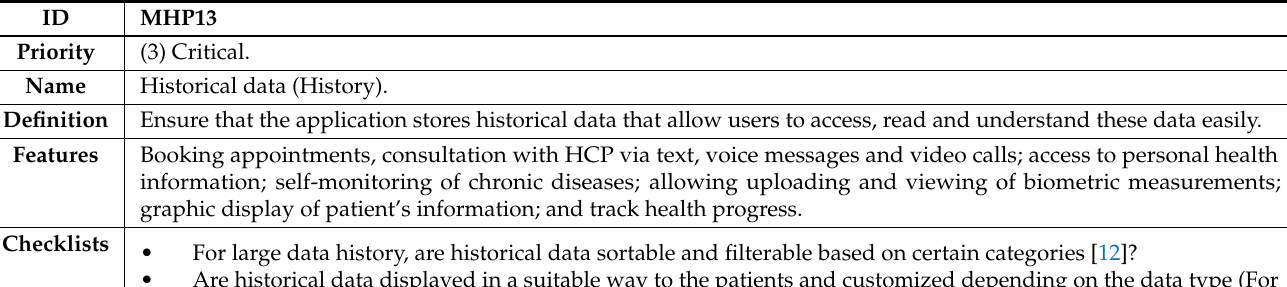
Table A13. Descriptive details of the thirteenth guideline.